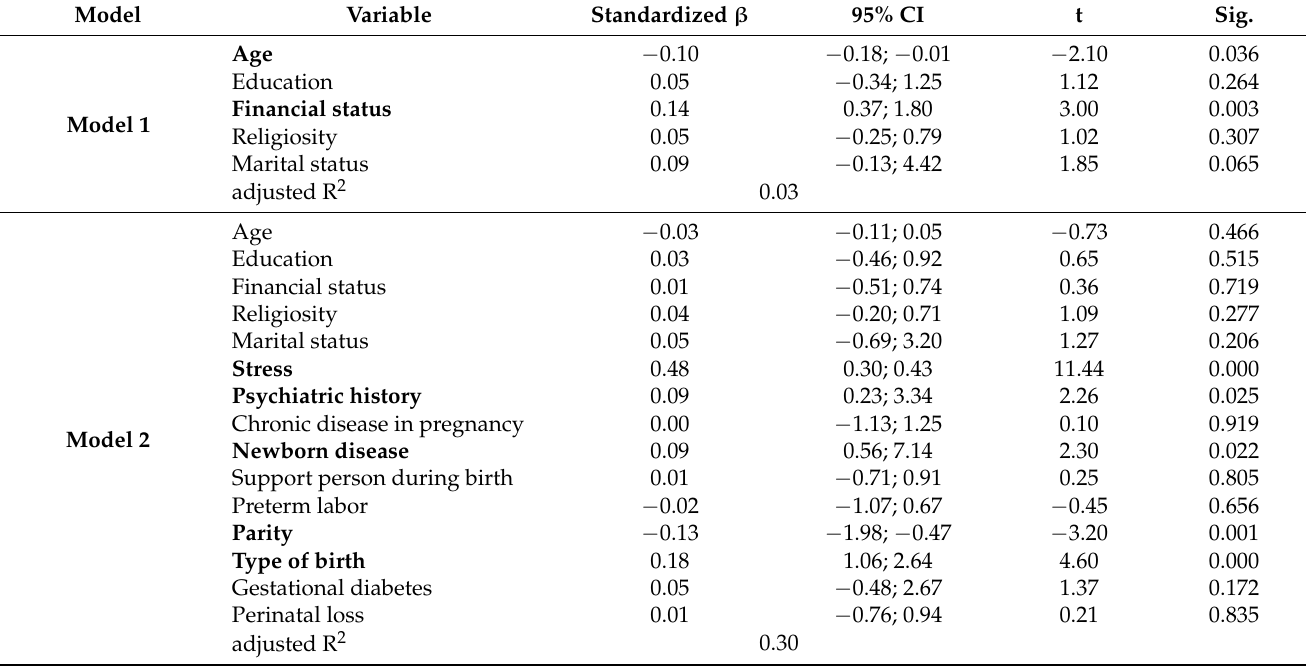
Table 4. Linear regression analysis of postpartum depression risk factors in a research